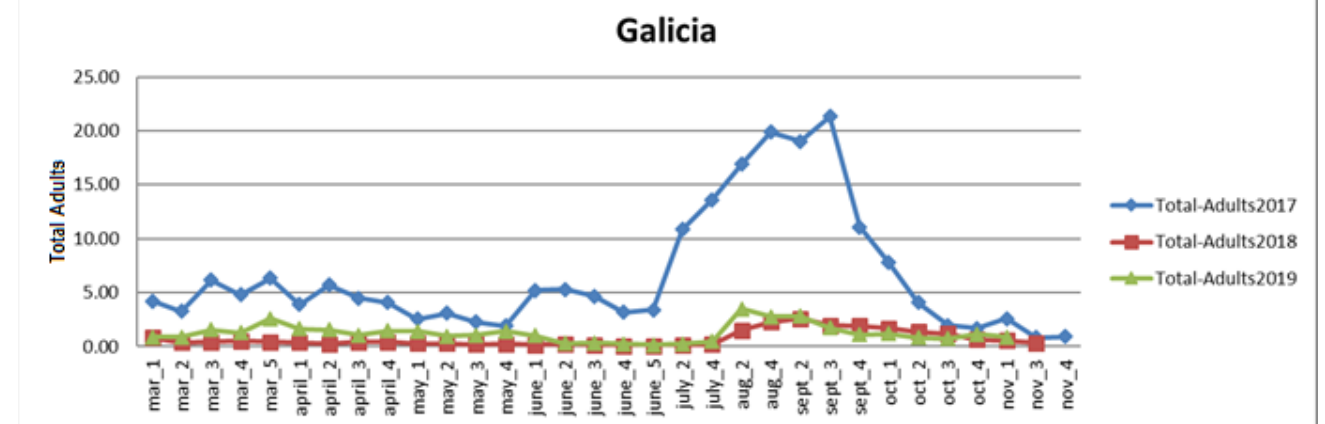
Figure 7. Mean values for total adults according to the week of the sampling month (visit).